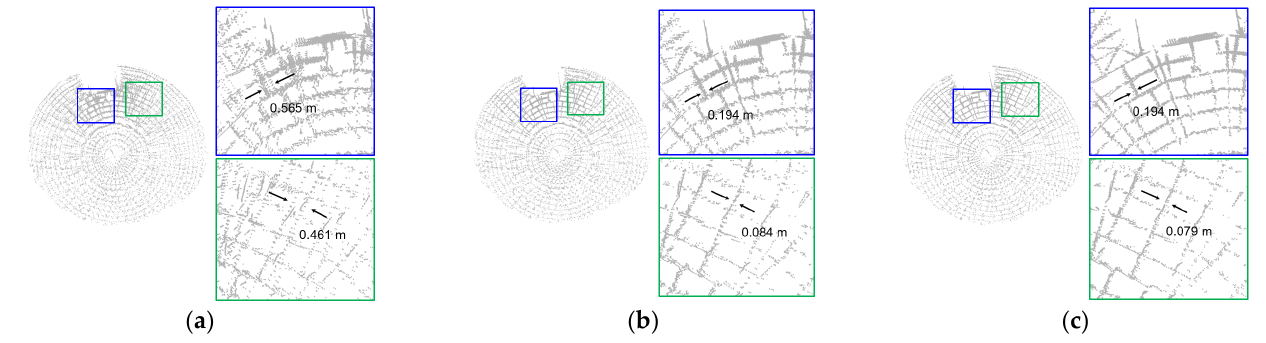
Figure 38. Extracted edge points from the scans in the Frankfort dataset showing the tangential alignment of the radial stringers after the: ( a ) partial fine registration using the roof feature, ( b ) partial fine registration using the ground/wall features, and ( c ) full fine registration using the roof/ground/wall features.